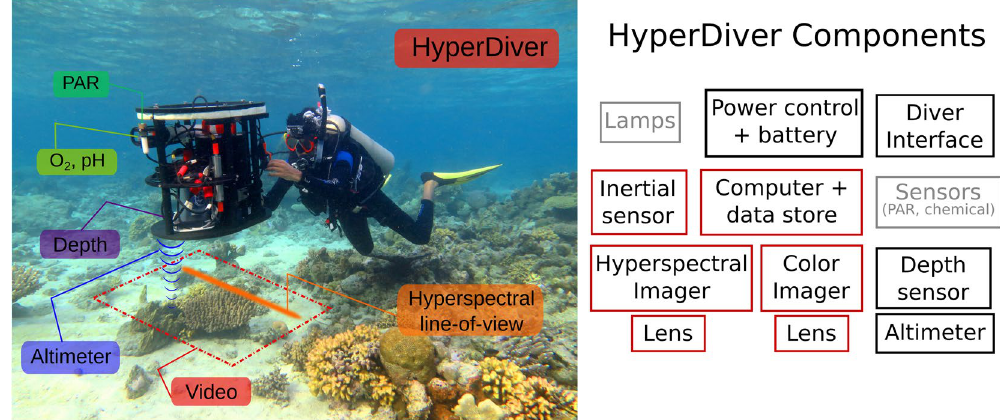
Figure 1. The HyperDiver system operated by a SCUBA diver to survey a shallow coral reef. The system simultaneously captures hyperspectral and color images, bottom altitude, depth, irradiance and chemical parameters. The field-of-view of the imagers depends on the altitude from the bottom, and the hyperspectral images can deliver centimeter-scale spatial resolution. The neutrally buoyant system can be easily navigated along transects following standard survey sampling protocols. The schematic shows the components of the system, with the instruments inside the main cylinder in red and optional components in gray. Details of the weight and cost of the system are in the supplement. (Photo by Sam